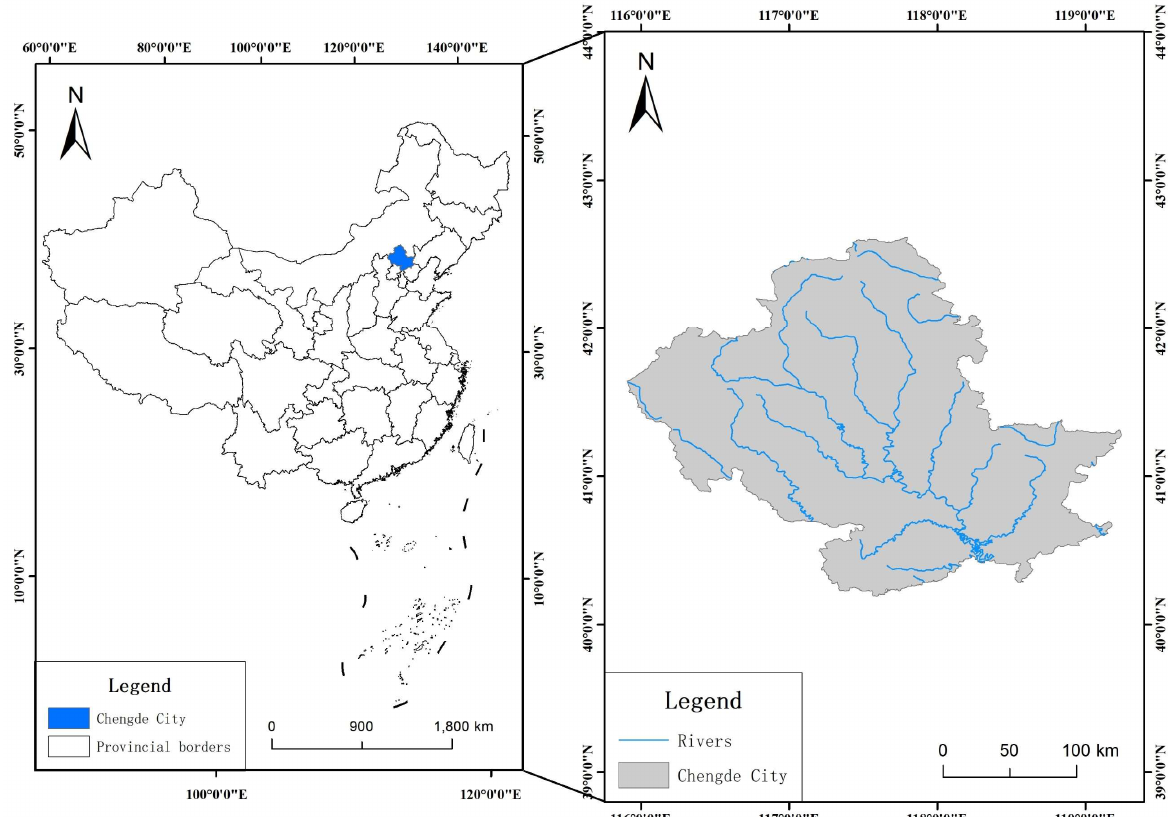
Figure 2. The study area.